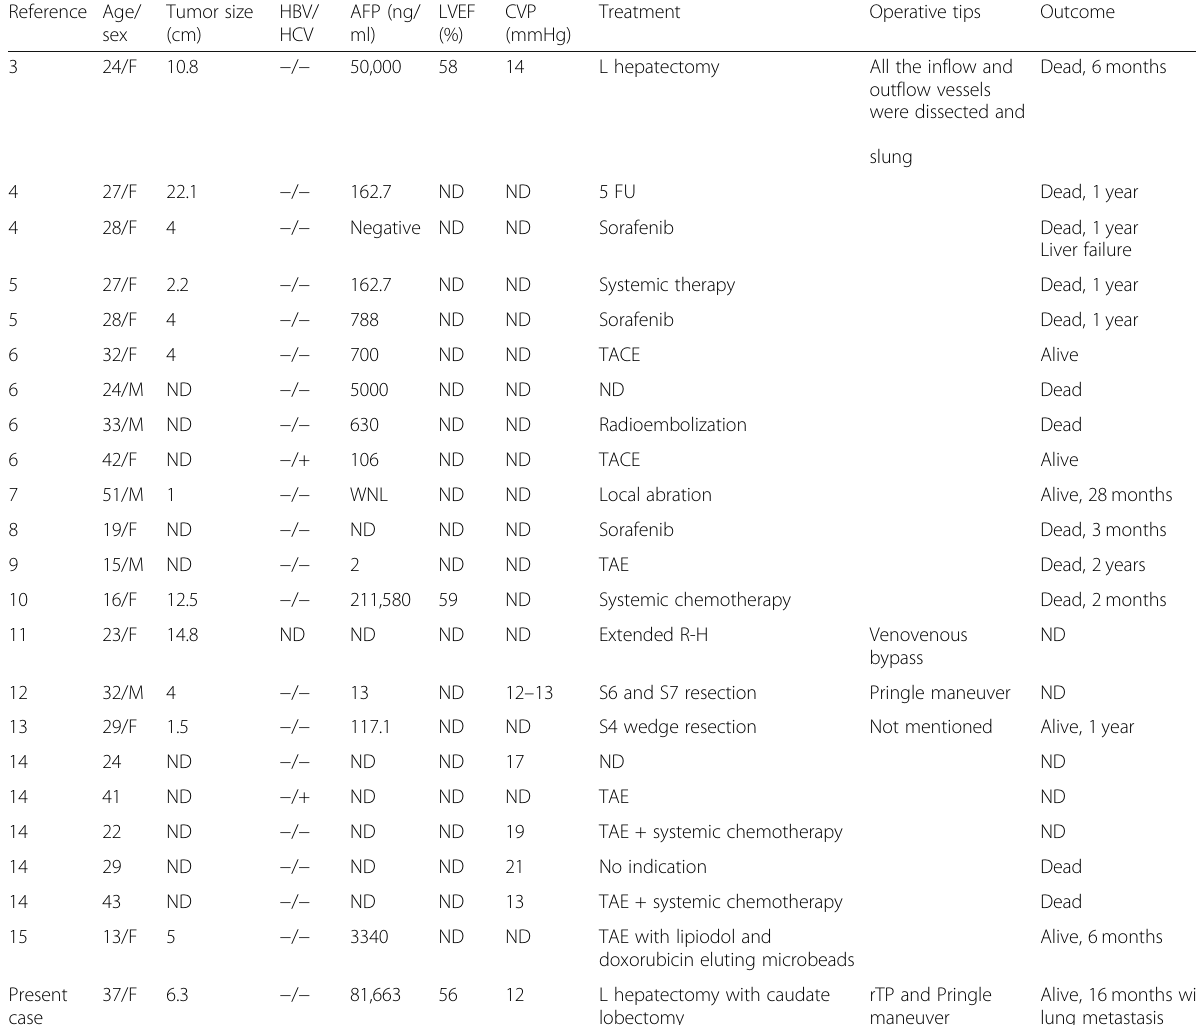
Table 1 Case of HCC with